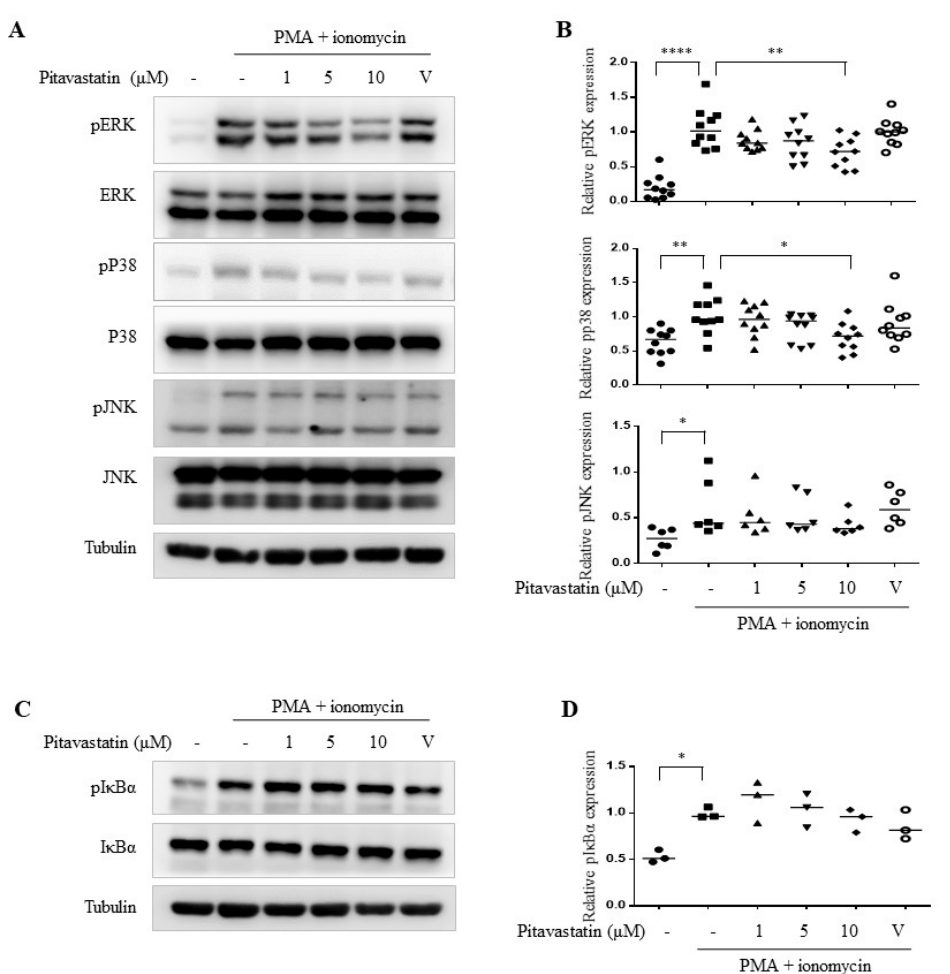
Figure 3. Pitavastatin significantly blocked the activation of both extracellular signal-regulated kinase (ERK) and p38 mitogen-activated protein kinases (MAPKs) in PMA + ionomycin-activated primary T cells. ( A ) Human primary T cells were pretreated with indicated pitavastatin concentrations for 2 h and were subsequently stimulated with PMA (5 ng / mL) + ionomycin (1 µ M) for 1 h. Collected cell lysates were analyzed through western blots. Representative data of 6–10 independent experiments were shown. ( B ) Quantitative results of ( A ) were shown. ( C ) Human primary T cells were cultured as ( A ) and the cell lysates were collected for the western blot assay. Representative data of three independent experiments were shown. ( D ) Quantitative results of ( C ) were shown. V indicates vehicle control. Quantitative data ( B , D ) were expressed as the median with individual data of 3–10 independent experiments. Significance were represented as * p < 0.05, ** p < 0.01, and **** p < 0.0001 versus PMA + ionomycin-stimulated group).